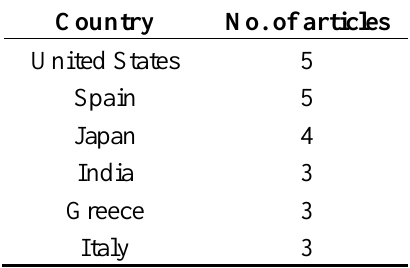
Table 1. Top six countries by the number of journal articles.